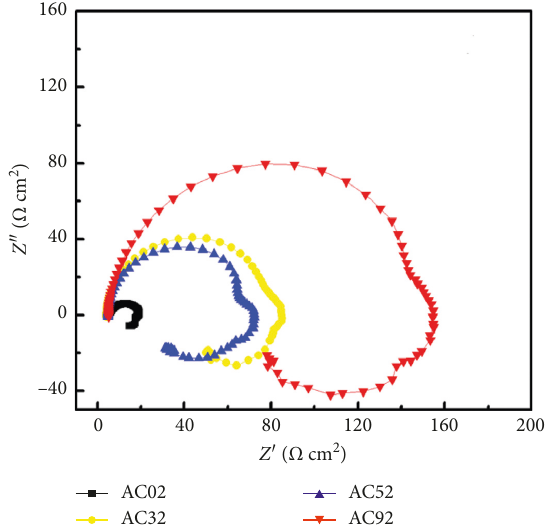
Figure 8: Nyquist plots of the as-cast ACx2 alloys in 3.5% NaCl